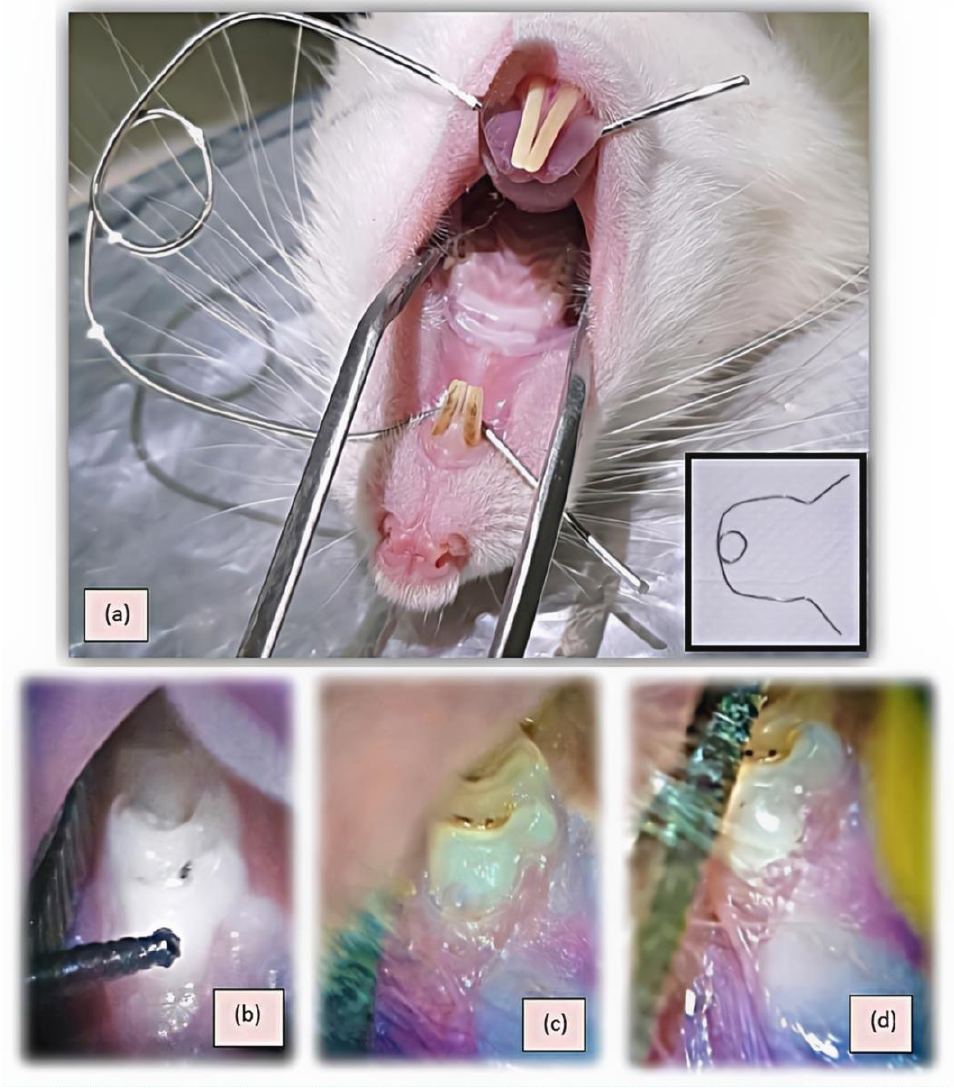
Figure 1. ( a ) Customized design wire loop and tweezer in place for mouth retraction. ( b ) Bur in position for cervical cavity preparation on a molar. ( c ) Prepared cervical cavity ( d ) Cervical restoration in